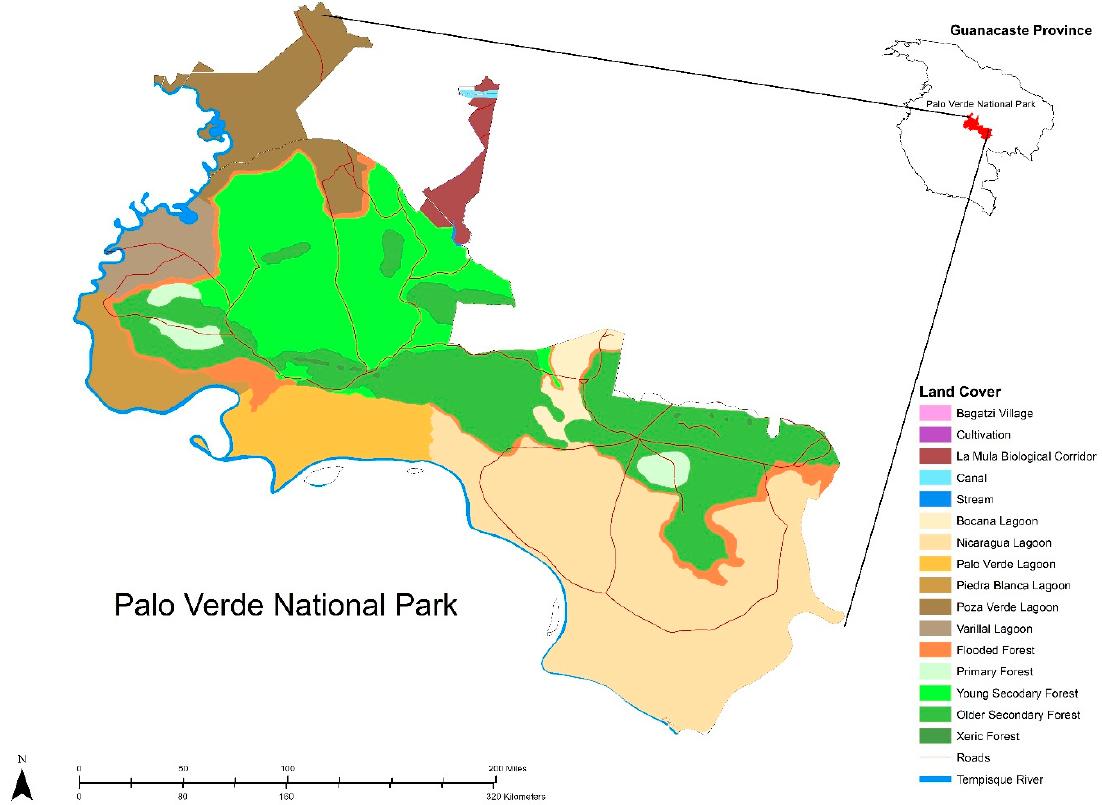
Figure 1. Map of the study site. Palo Verde National Park in Guanacaste showing distribution of land-cover within the area.